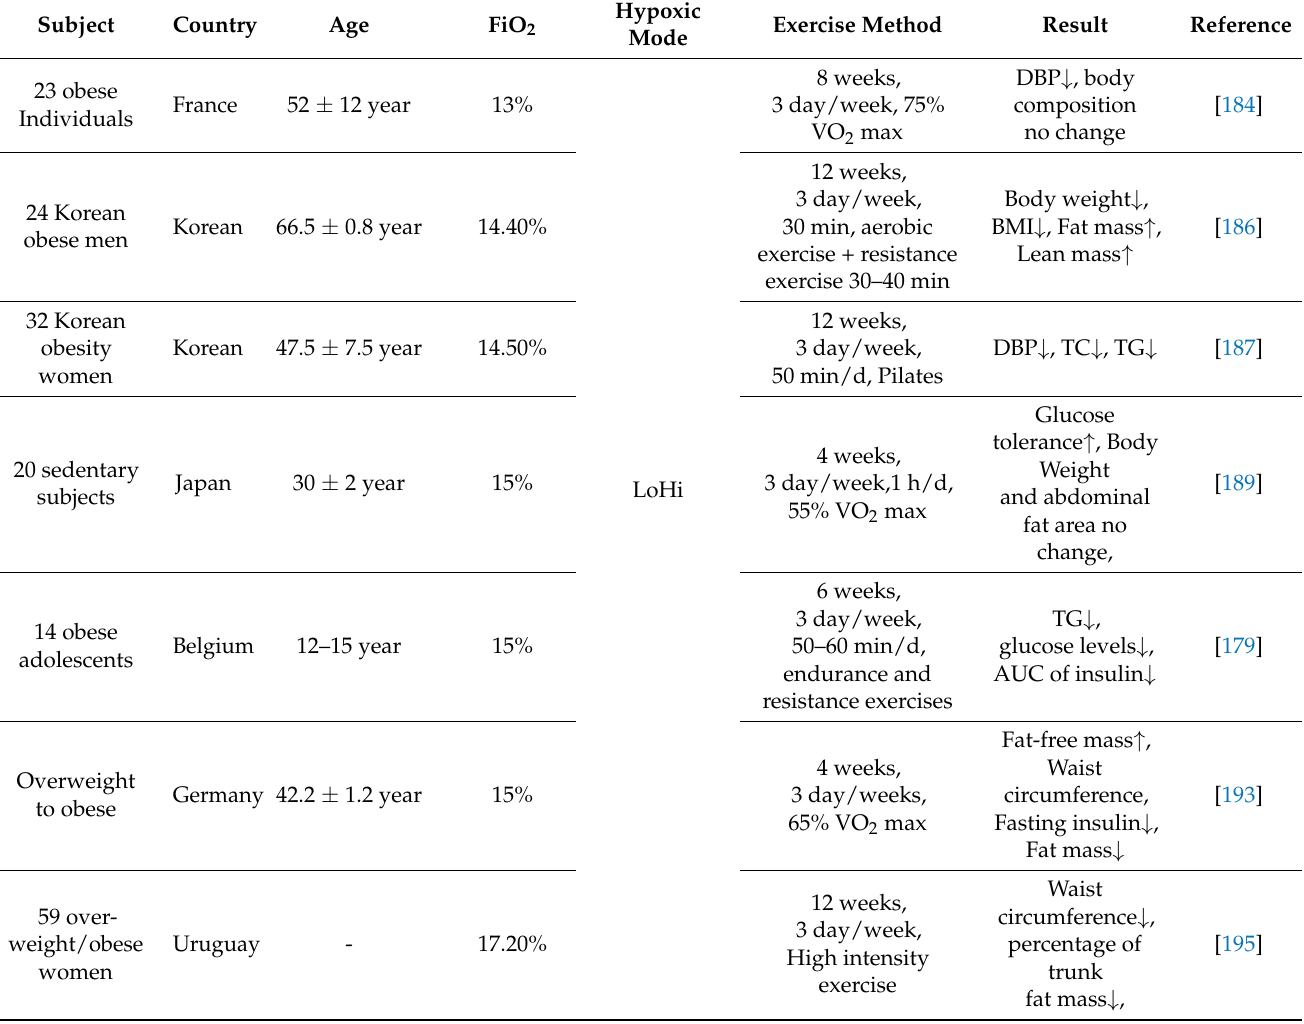
Table 1. Intervention effects in obese patients under different hypoxic